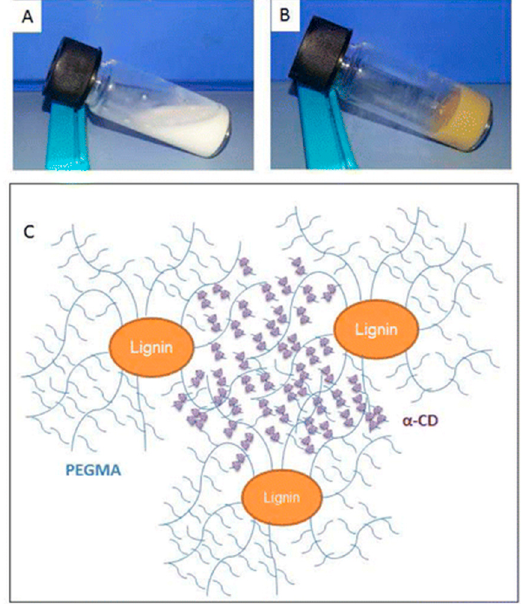
Figure 11. ( A ) inclusion complex suspension of PEG and α -CD) and ( B ) hydrogel of PEG/lignin/ α - CD) and ( C ) Kai et al. proposed structure of lignin-based supramolecular hydrogel. (Reproduced with permission from Kai et al. [69]. Copyright (2015) American Chemical Society.